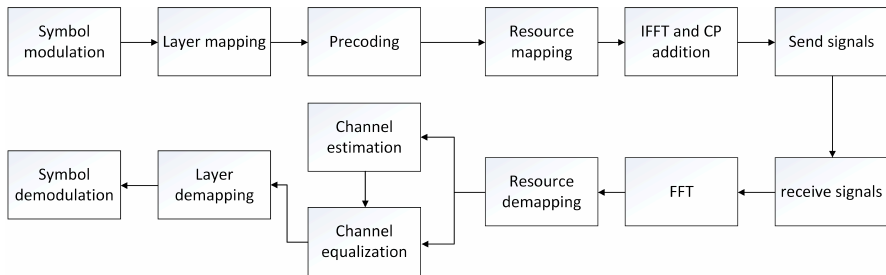
Figure 1. 5G flow chart of uplink channel estimation.